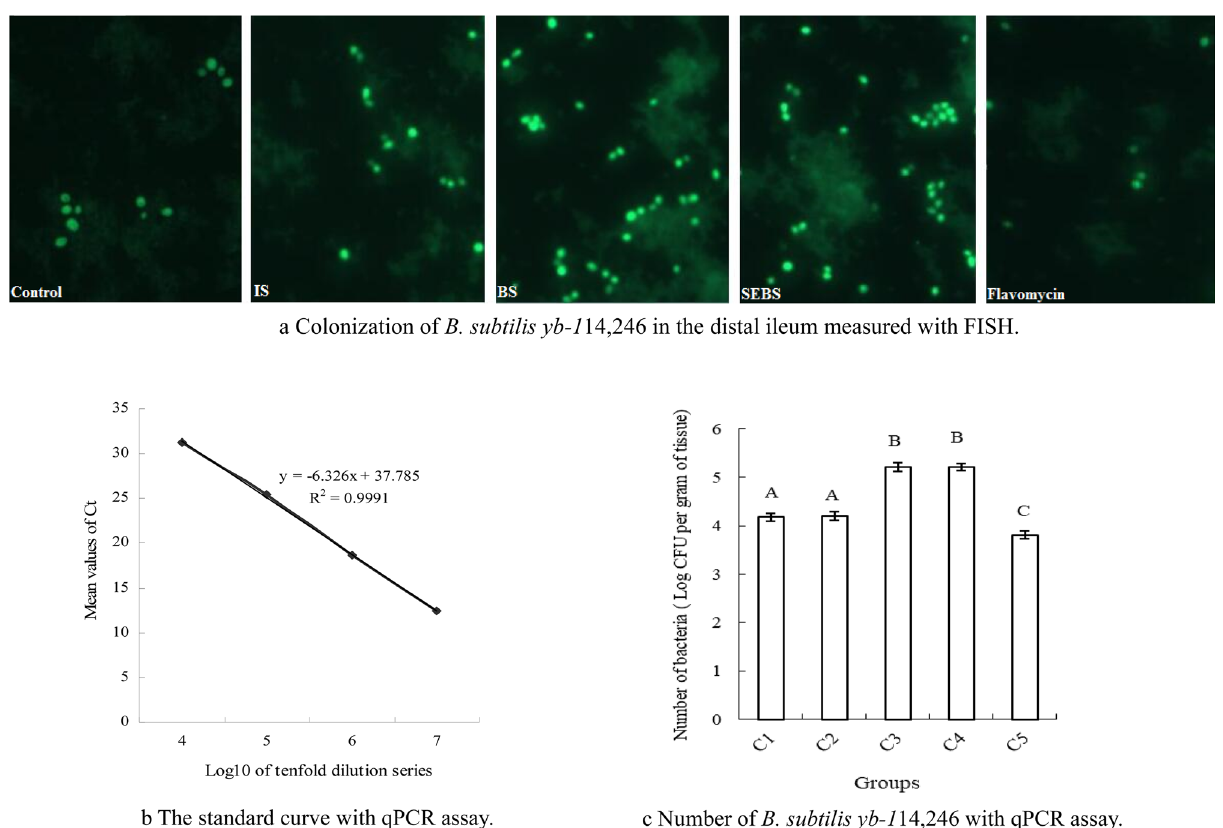
Figure 2. Colonization of B. subtilis yb-1 14,246. ( a ) B. subtilis yb-1 14,246 in the distal ileum was detected with FISH and ( b ) the total number of B. subtilis yb-1 14,246 estimated based on a standard curve by qPCR assay ( c ). Values represented by vertical are means, with standard errors are represented by vertical bars. Significant differences from the control group were determined by one-way ANOVA followed by Duncan’s multiple comparison tests: superscript capital letters in columns mean P < 0.01. The Microsoft Office Excel 2010 was used to as the stamp